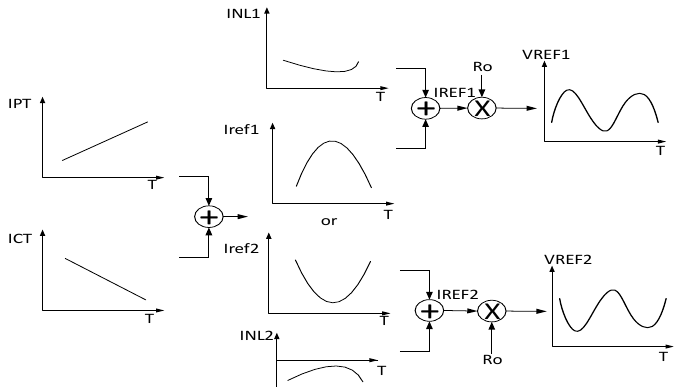
Figure 2. Square curvature compensation principle. IPT represents IPTAT; ICT represents ICTAT; Iref1,2 represent two typical current curves after first-order temperature compensation; INL1,2 represent two non-linear compensation current; Vref1,2 represent reference voltage after high-order temperature compensation.